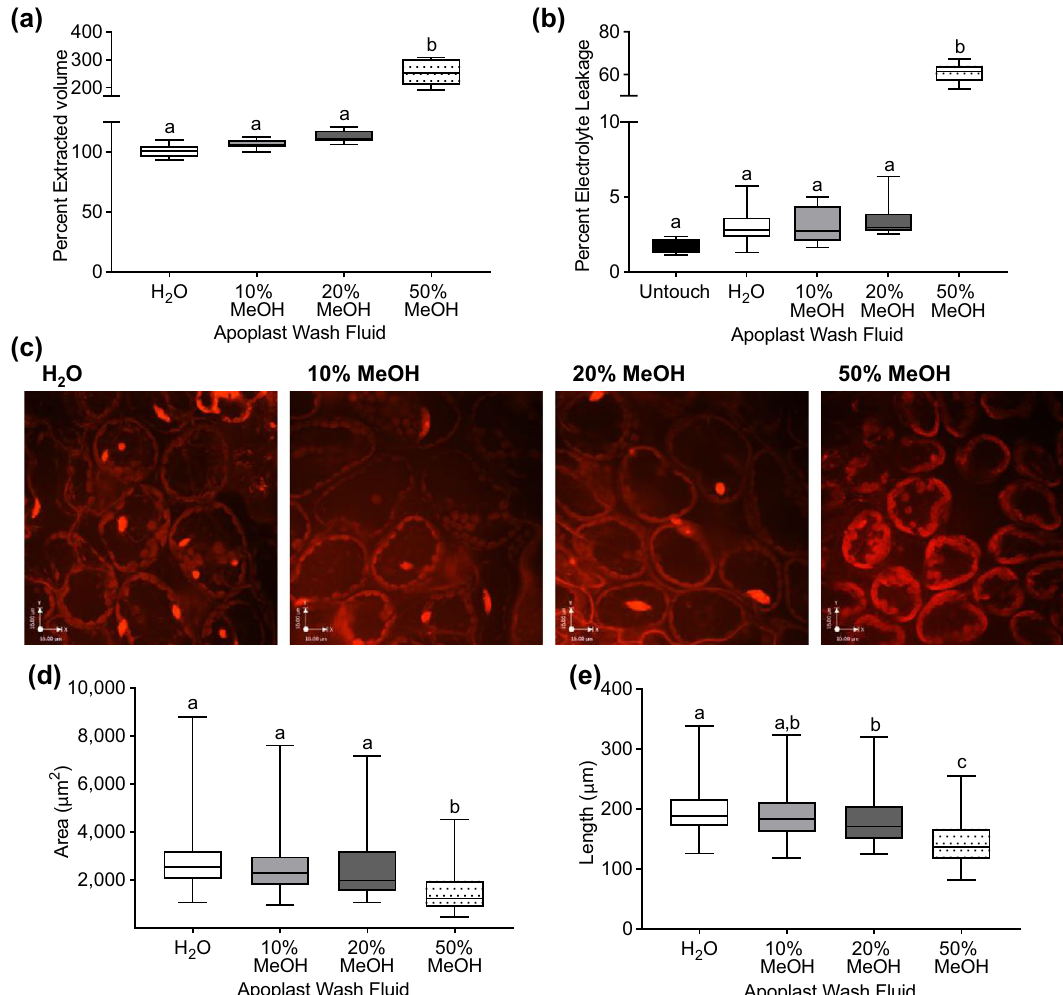
Figure 5. Evaluation of apoplast wash fluids. ( a ) Percent extracted volume of apoplast from Arabidopsis leaves after vacuum-infiltration with H 2 O, 10%, 20% or 50% methanol. For each experiment, n = 3 samples/ infiltrate and combined data from three independent experiments (n = 9) is shown. ( b ) Percent electrolyte leakage from untouched leaves and from the post-processing leaves of ( a ). ( c ) Fully expanded, 5.5 week-old Arabidopsis leaves were vacuum-infiltrated with H 2 O, 10%, 20% or 50% methanol and leaf punches were stained with 10 µg/µl propidium iodide (PI) for 30 min at 26 °C. The leaf punches were imaged with a spinning disk confocal microscope. Shown are representative maximum-intensity projection images of PI fluorescence. Scalebars = 16 µm. ( d ) For samples as in ( c ), area ( d ) and perimeter ( e ) of the cells were measured using Fiji. For ( d ) and ( e ), 4–5 cells per image were measured from 25 to 30 images per treatment from three independent experiments. Boxes indicate the median and interquartile range and whiskers indicate minimum and maximum data distribution. Different letters denote statistically significant difference based on ordinary one-way ANOVA and Tukey’s multiple comparisons test ( p <